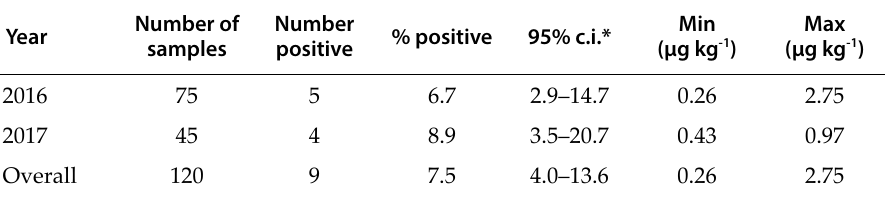
Table 3. Results by year of sample